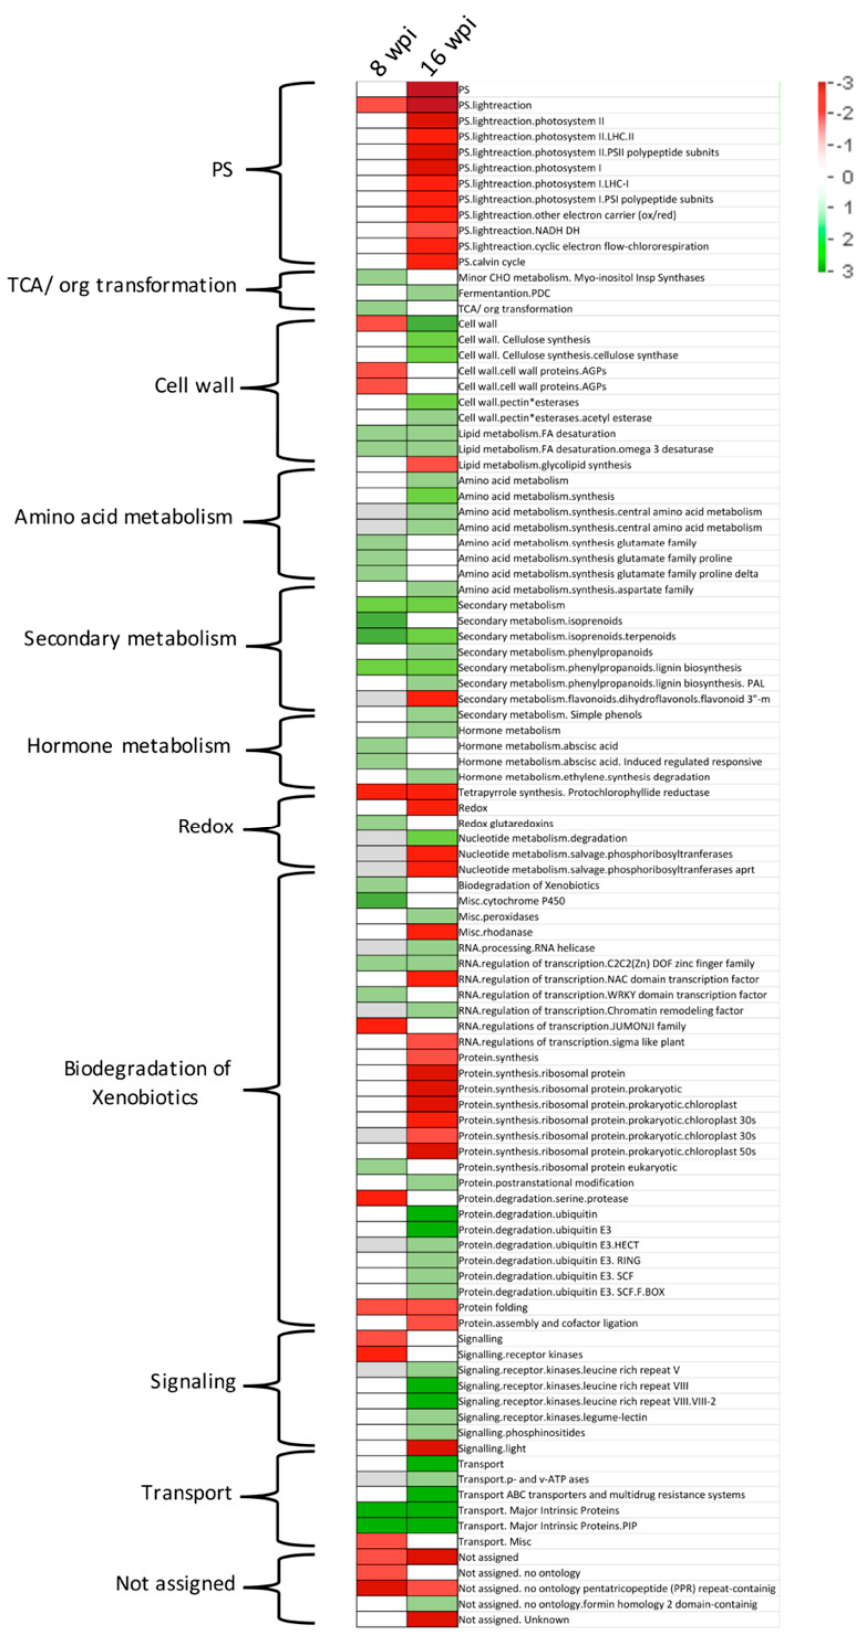
Figure 8. Metabolic pathways categorization analysis. PageMan functional enrichment of differentially expressed genes. Red, downregulated functional categories; green, upregulated functional categories.